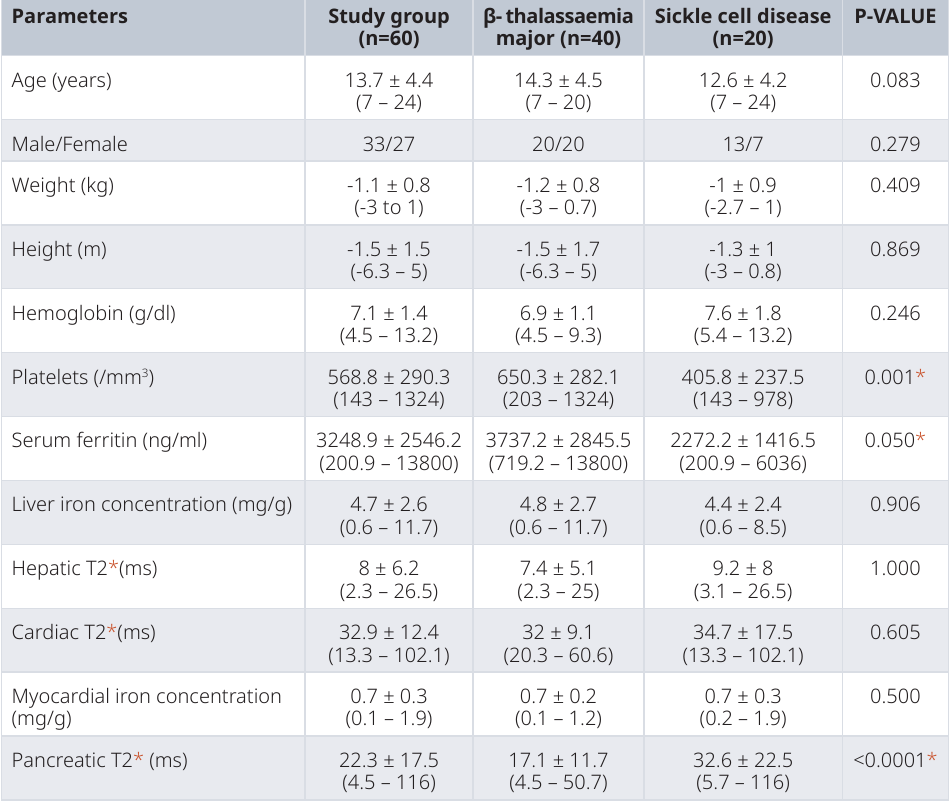
Table 1. Clinical, laboratory and iron profile data of the studied patients. Data are expressed as mean±SD (range).